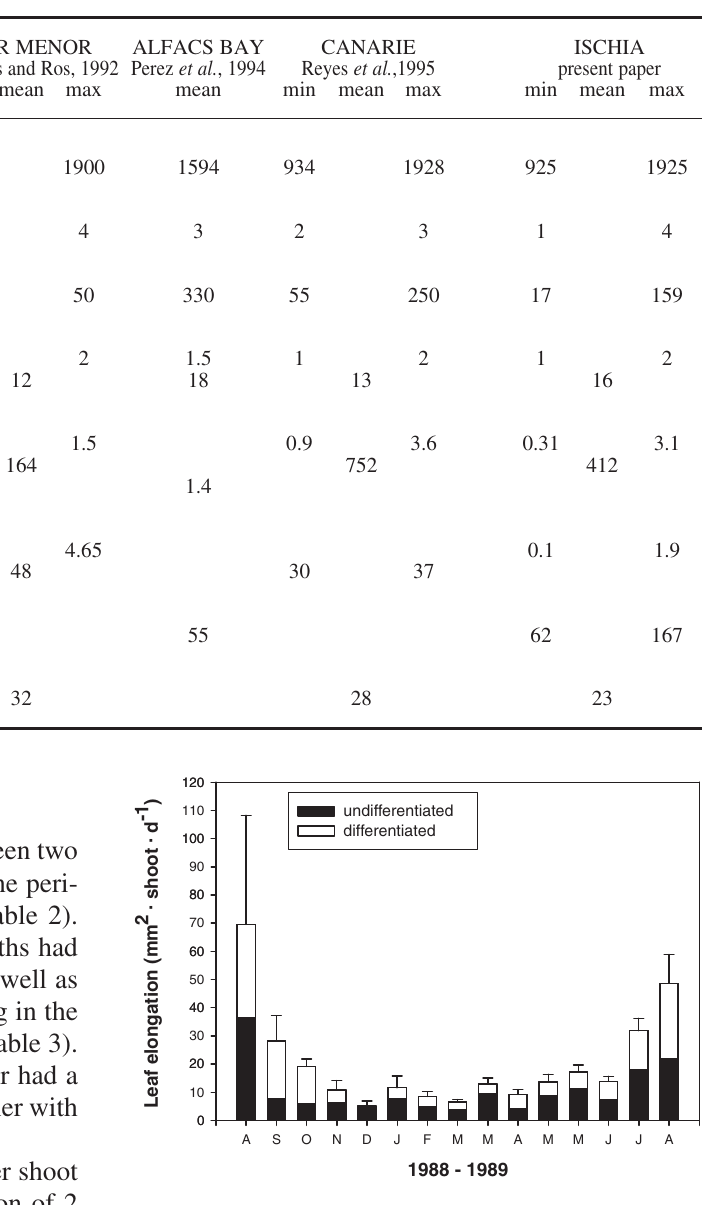
F IG . 9. – Annual pattern of daily leaf growth for leaves of different age class ( standard deviations are related to the total mean leaf